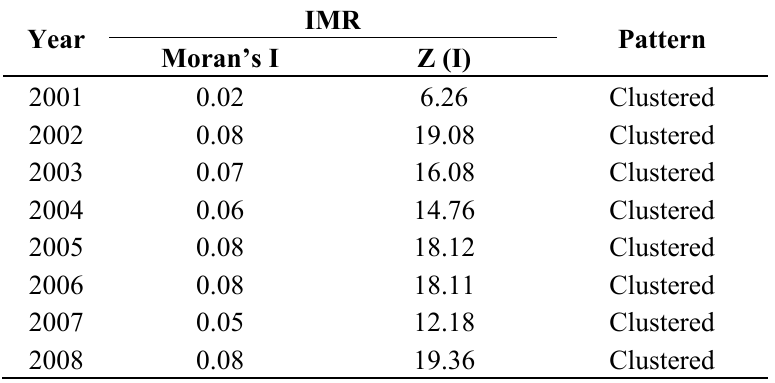
Table 4. Global spatial autocorrelation analysis of IMR.